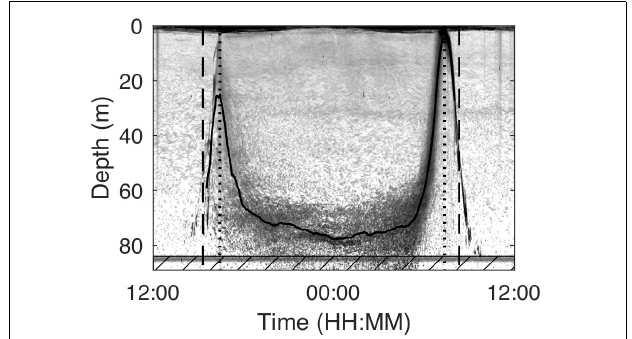
FIGURE 2 | Example echogram from January 22, 2011 as recorded by a 200 kHz echosounder deployed at around 92 m depth in Masfjorden with annotations showing the results of the scattering layer description. The solid line indicates the depth of the middle of the scattering layer. Dashed lines indicate the start of the dusk descent (beginning of midnight sinking) and the end of the dawn ascent (end of midnight sinking). Interrupted lines show the time of sunset and sunrise on that day. The line at around 84 m depth is noise. Data in the hatched box in the lowest part of the echogram were not included in the scattering layer description due to that noise, but were included during target